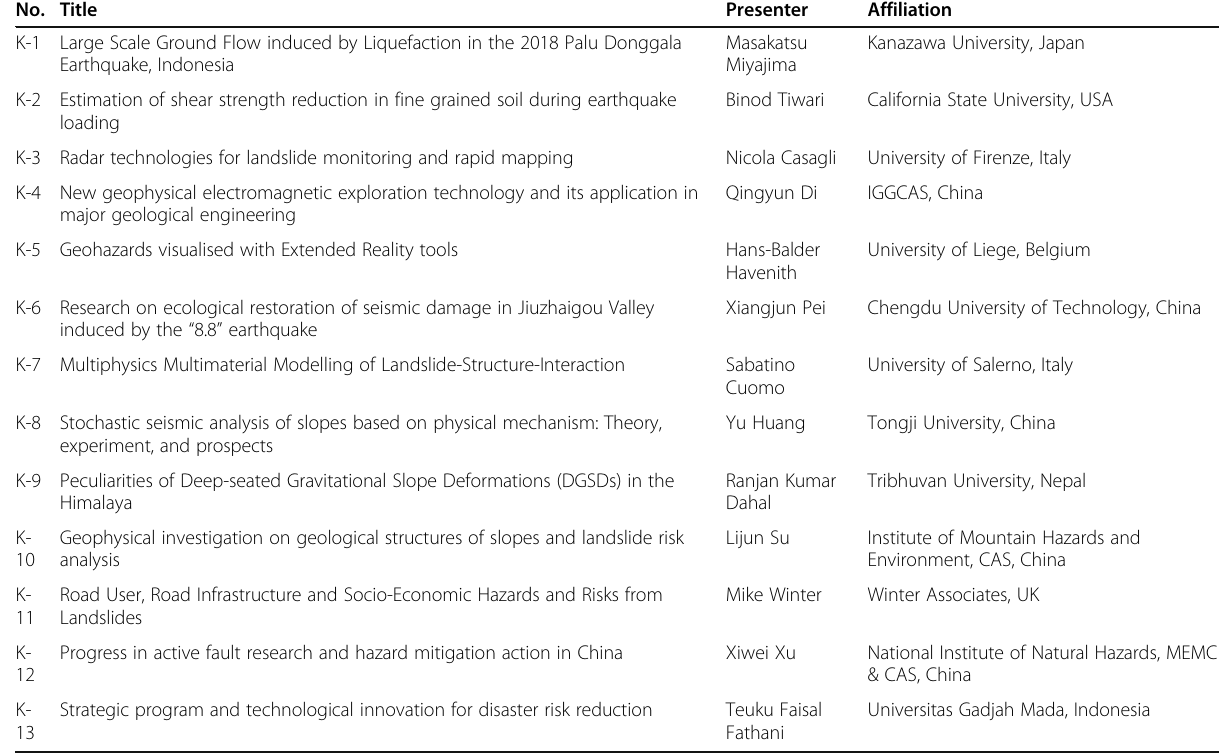
Table 1 Lists of the presentation in Keynote